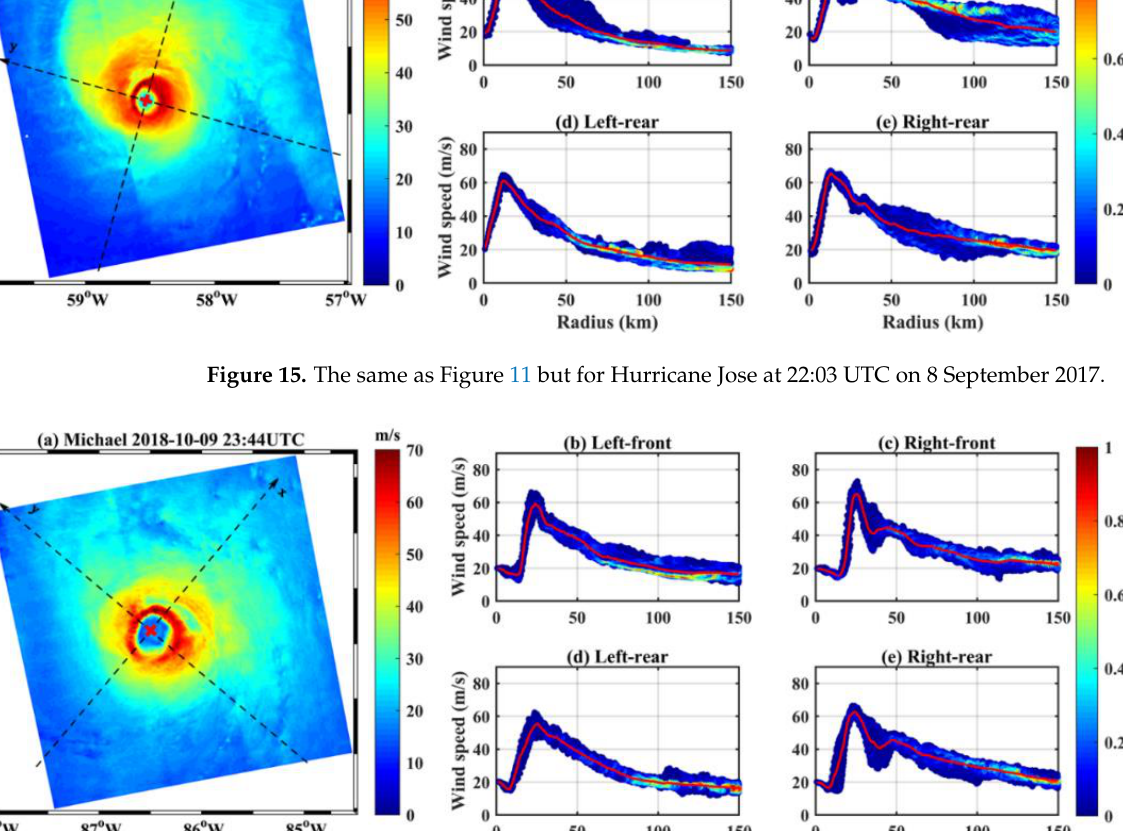
Figure 17. The same as Figure 11 but for Hurricane Michael at 11:50 UTC on 10 October 2018. 5. Conclusions In this study, 444 radial legs from a reconnaissance aircraft were collected. A total of 116 radial legs during Hurricane Irma sampled four ERC processes at both the sea-surface and free-atmosphere levels. 328 radial legs during the six other hurricanes were used for